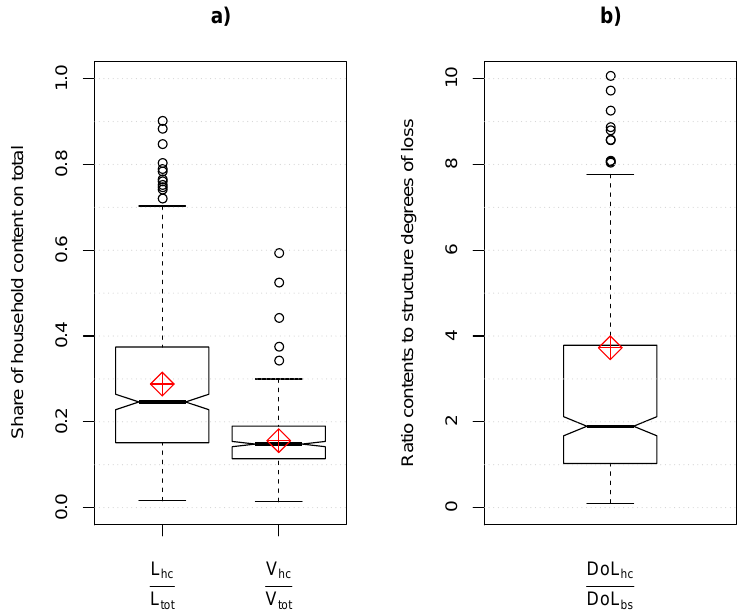
Figure 2. ( a ) Left : Share of the household content loss ( L hc ) on the total building loss ( L tot = structure loss + content loss). Right : Share of the insurance sum of household contents ( V hc ) on the total insurance sum of a building ( V tot ). ( b ) Ratio of the degree of loss on household contents ( DoL hc ) to the degree of loss on structure ( DoL bs ) for the same building. The red diamond symbols indicate the corresponding mean